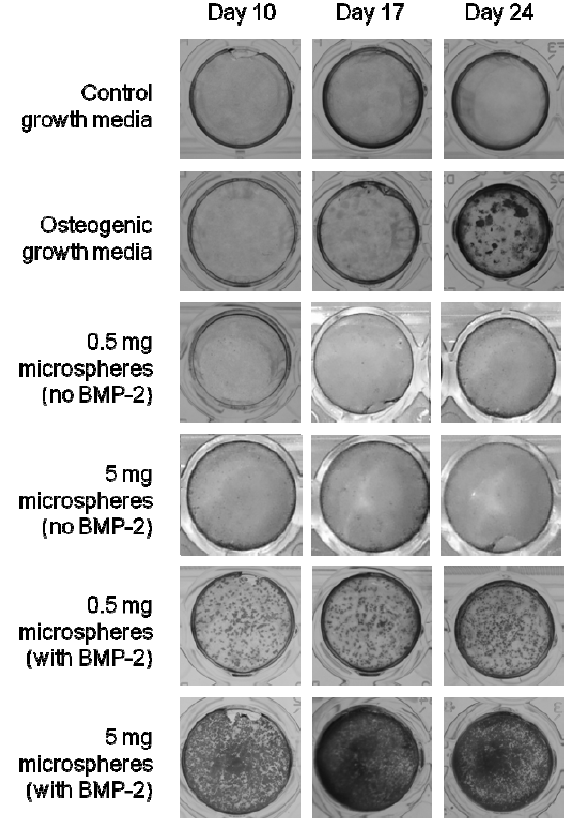
Figure 6. Representative light photographs of tissue culture wells stained with alizarin red to identify calcium deposits in the MC3T3-E1 culture in the presence of PLGA/PLGA- PEG-PLGA composite microparticles with and without BMP-2 inclusion at day 10, 17 and 24. Groups were: control media (no microparticles), osteogenic media (no microparticles) 0.5 mg of blank microparticles (no BMP-2), 5 mg of blank microparticles (no